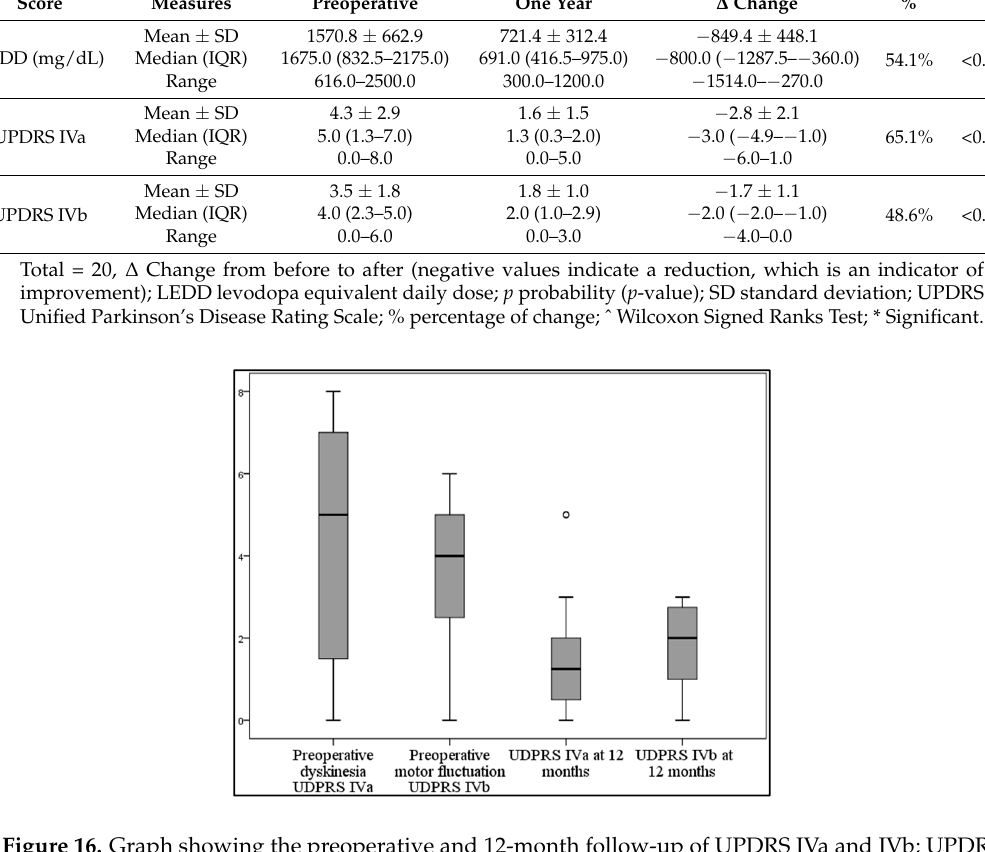
Figure 16. Graph showing the preoperative and 12-month follow-up of UPDRS IVa and IVb; UPDRS Unified Parkinson’s Disease Rating Scale.